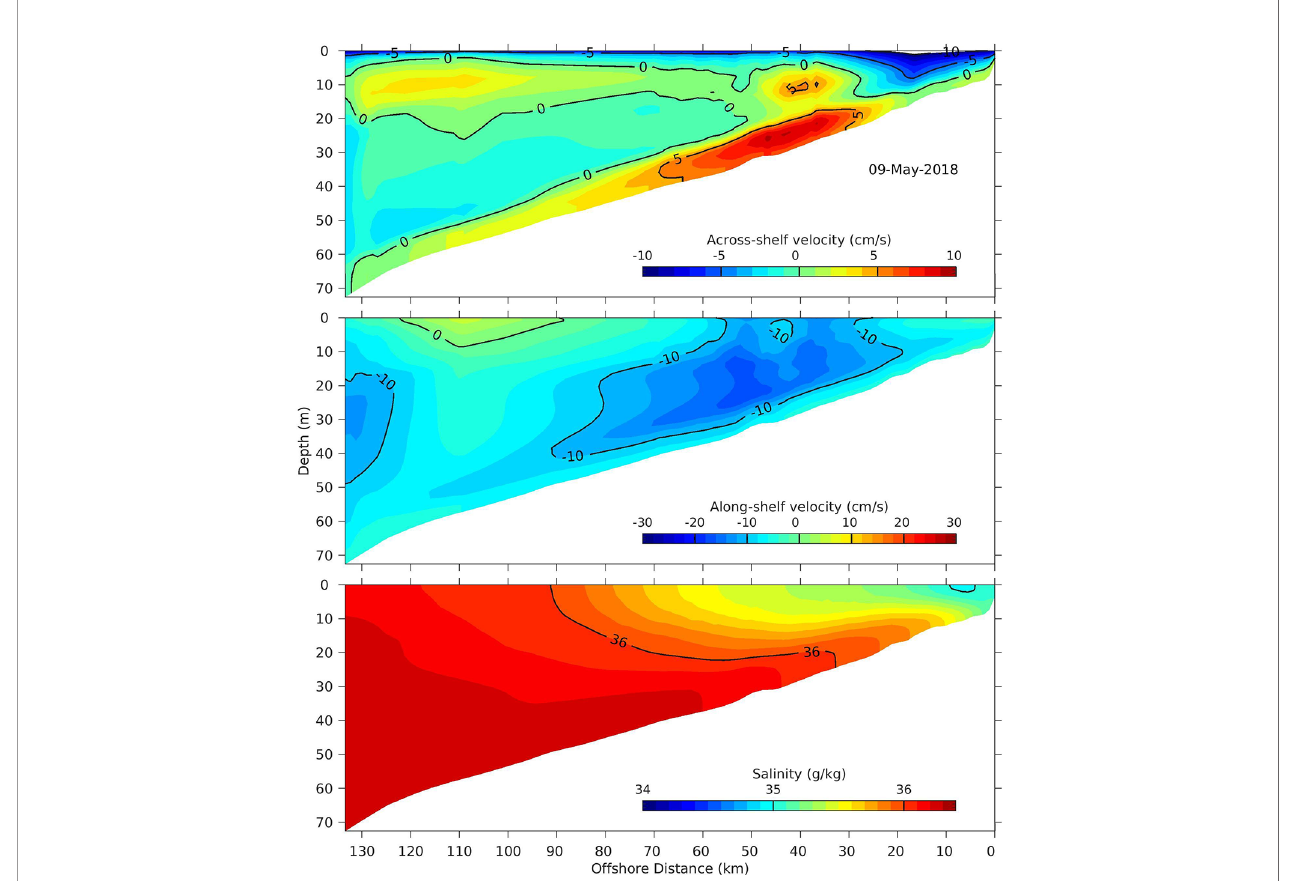
FIGURE 5 | Across-shelf sections sampled offshore from Sarasota, FL on May 9, 2018 from a West Florida Coastal Ocean Model simulation. From top to bottom are the across-shelf component of velocity, the along-shelf component of velocity and salinity, with contour intervals and units provided by the color bars in each